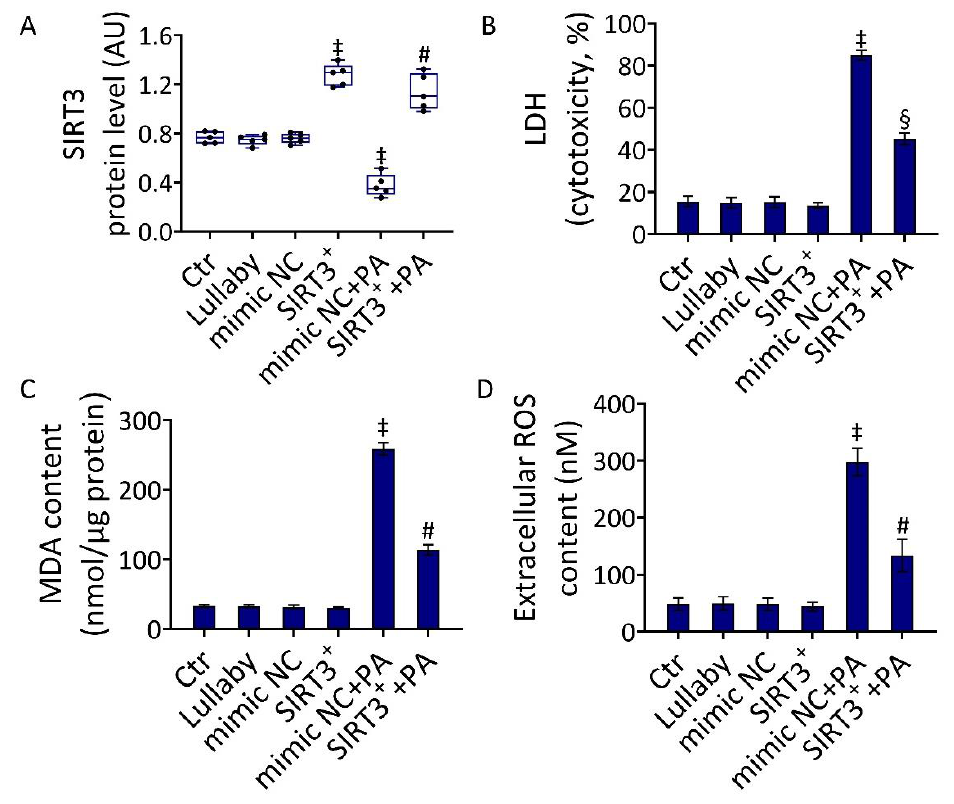
Figure 2. SIRT3 + reduced the PA-related cytotoxicity. ( A ) Immunoblotting analysis of SIRT3 protein levels, ( B ) LDH assay cytotoxicity, ( C ) MDA, and ( D ) extracellular ROS content in EC treated with the empty transfection reagent (Lullaby) or transfected with mimic Negative Control (mimic NC), SIRT3 mimic (SIRT3 + ), mimic Negative Control and then exposed to 0.5 mM PA for 48 h (mimic NC+PA) or SIRT3 mimic before 48 h treatment with PA (SIRT3 + +PA). Control cells (Ctr) were treated with the corresponding volume of HBSS-10 mM Hepes. Western blotting results ( n = 5) are ex- pressed as arbitrary units (AU) and represented as boxplots. ‡ p < 0.001 vs. mimic NC; § p < 0.05 vs. mimic NC+PA; # p < 0.01 vs. mimic